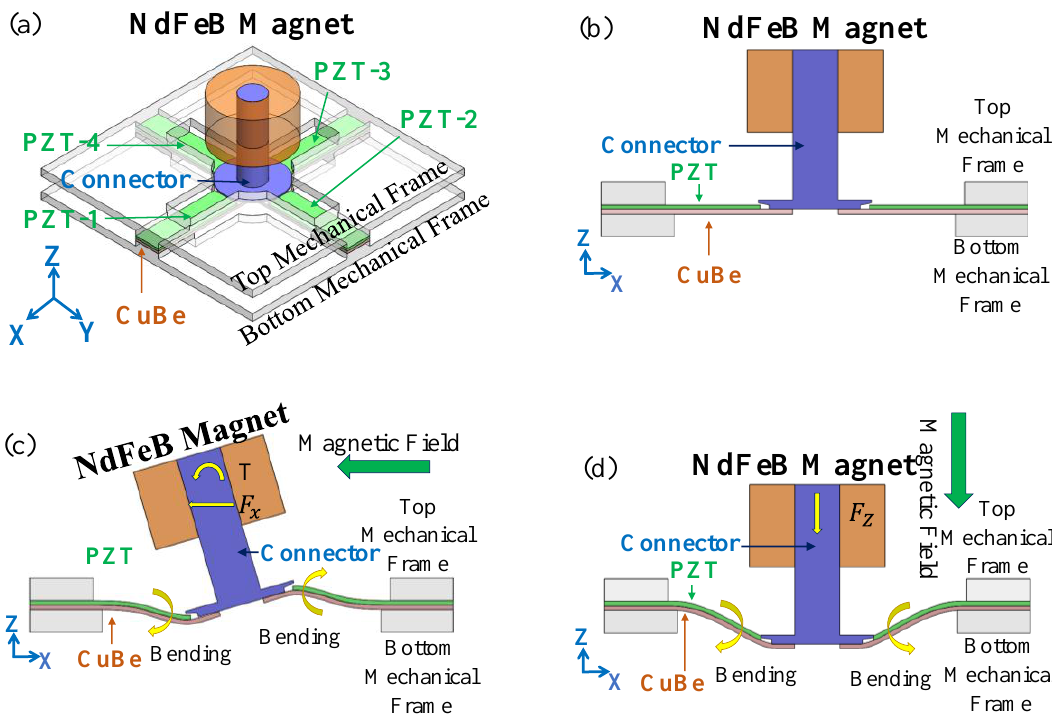
Figure 1. Magnetic-sensing principle of the 3-axis magnetic-force-based AC magnetic sensor: ( a ) isometric view of the sensor. The sensor is under ( b ) initial/static state; zero magnetic field and zero ambient vibration, ( c ) x -axis magnetic field, and ( d ) z -axis magnetic field.